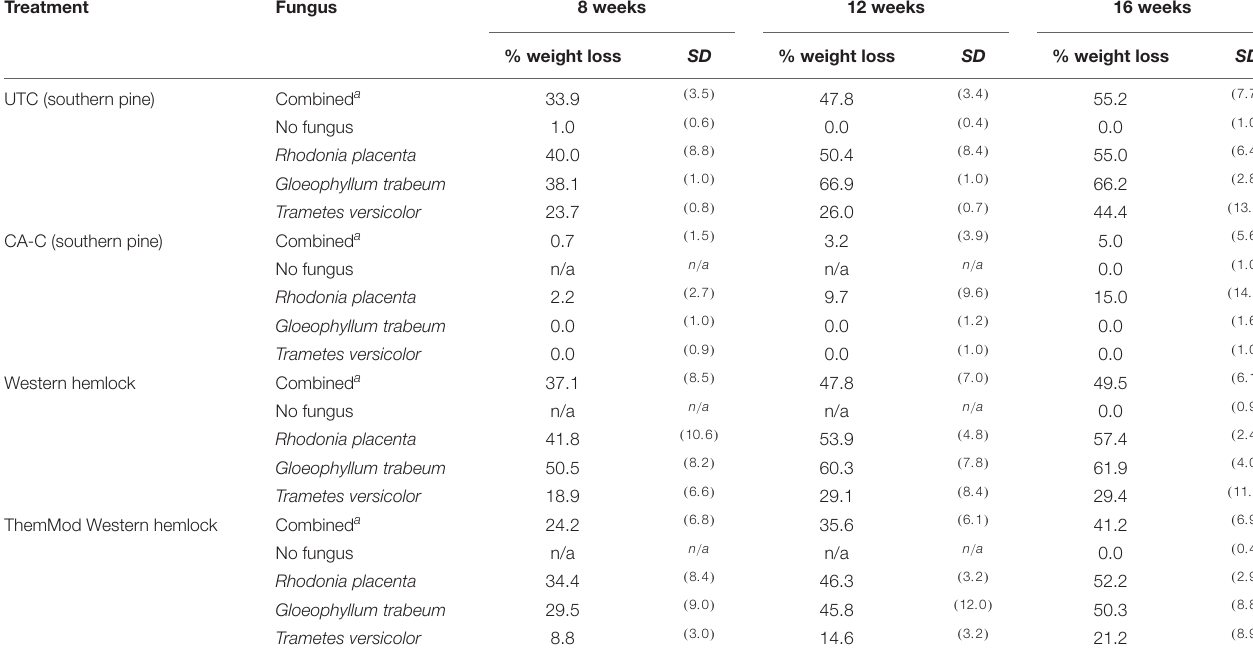
TABLE 2 | Mass loss in 19 mm blocks after exposure to one of two brown rot fungi or one white rot fungus for 8, 12, or 16 weeks. Treatment Fungus